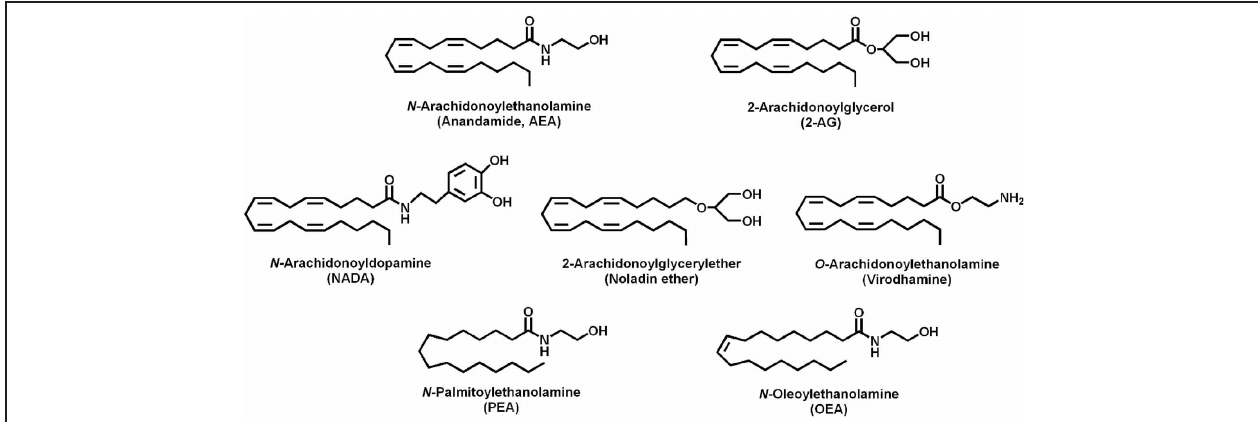
FIGURE 1 | Chemical structures of biologically active eCBs and of the eCB-like compounds.